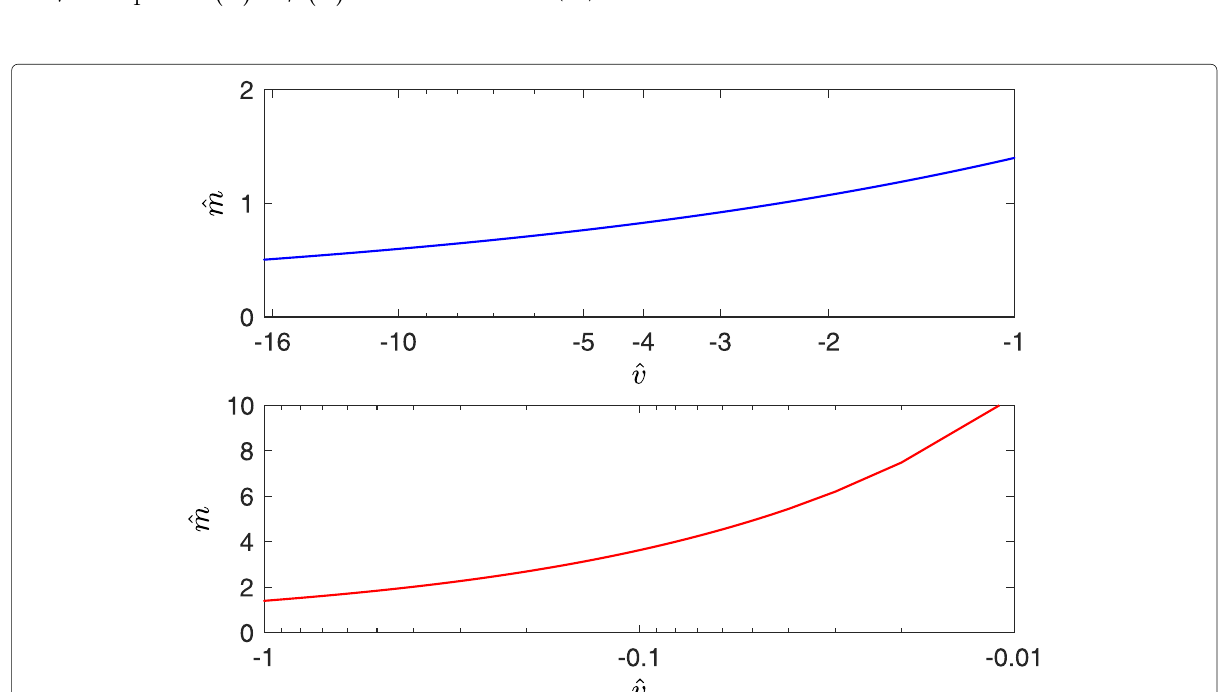
Fig. 1 Estimator of the Nakagami- m fading parameter, ˆ m , as a function of the ˆ v